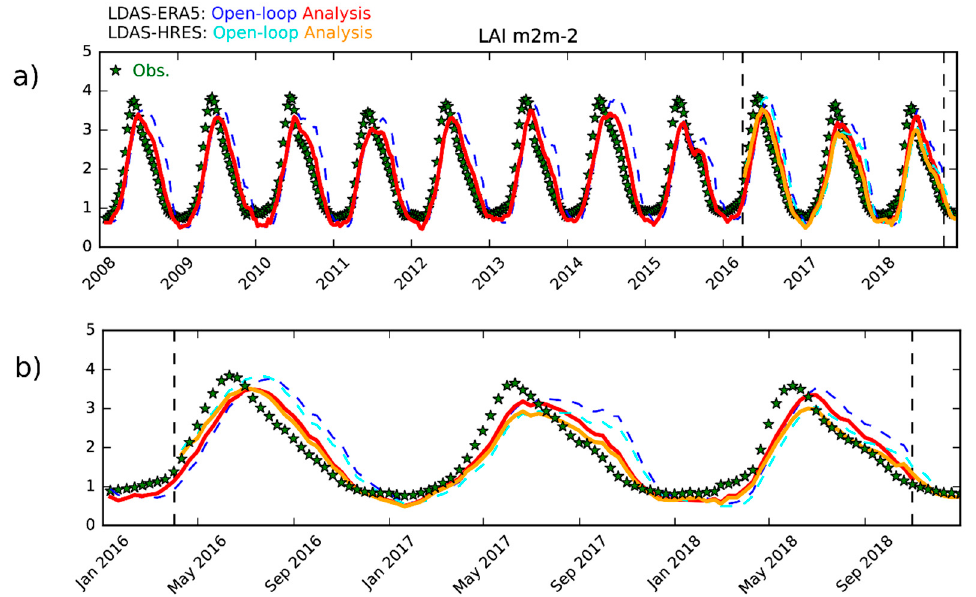
Figure 4. ( a ) Observed CGLS GEOV2 Leaf Area Index (LAI) (green stars) over January 2008 to